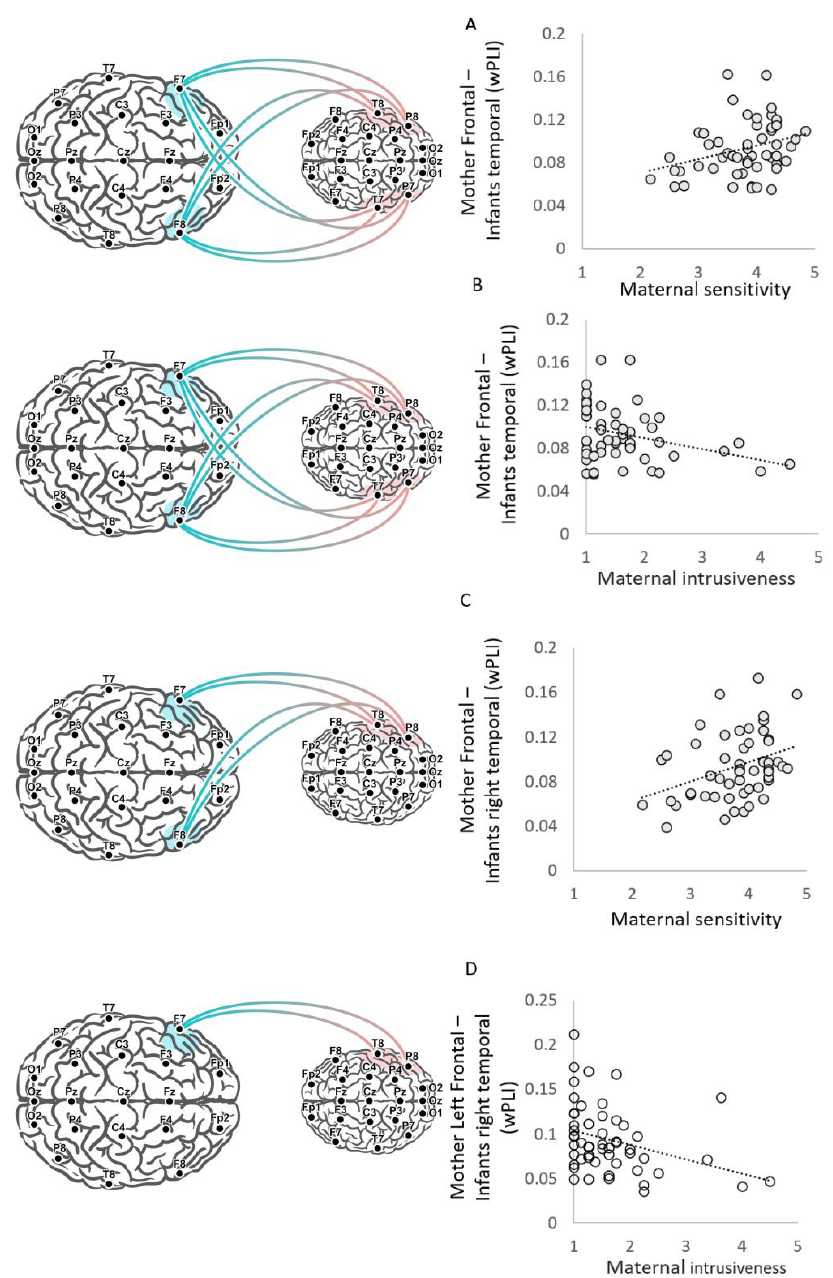
Figure 2. Visualization of brain–behavior correlations. Visualization of the CIB codes of maternal sensitivity and maternal intrusiveness correlations with wPLI values of frontal–temporal inter-brain neural synchrony and frontal–right temporal inter-brain neural synchrony. Mother-frontal–infant- temporal neural synchrony scores correlated with both ( A ) maternal sensitivity scores (N = 53, r = 0.31, p = 0.023) and ( B ) maternal intrusiveness scores (N = 53, r = −0 .28, p = 0.041). ( C ) Mother-frontal – infant-right-temporal neural synchrony scores correlation with maternal sensitivity scores (N = 53, r = 0.34, p = 0.013), and ( D ) mother-left-frontal – infant-right-temporal neural synchrony scores cor- relation with maternal intrusiveness scores (N = 53, r = −0 .39, p = 0.004).